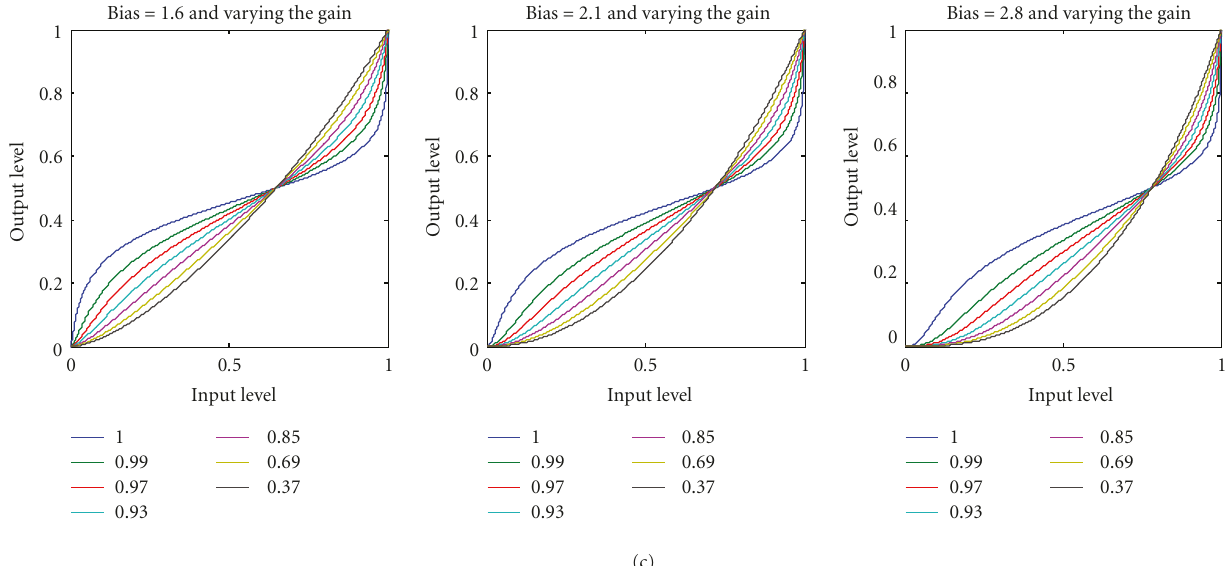
Figure 11: Inverse Hyperbolic Tangent Curve produced by varying the gain and bias values: (a) gain( x ) parameter fixed and varying the bias( x ) parameter, (b) bias( x ) parameter fixed and varying the gain( x ) parameter, (c) varying the gain and bias values of mapping curves.